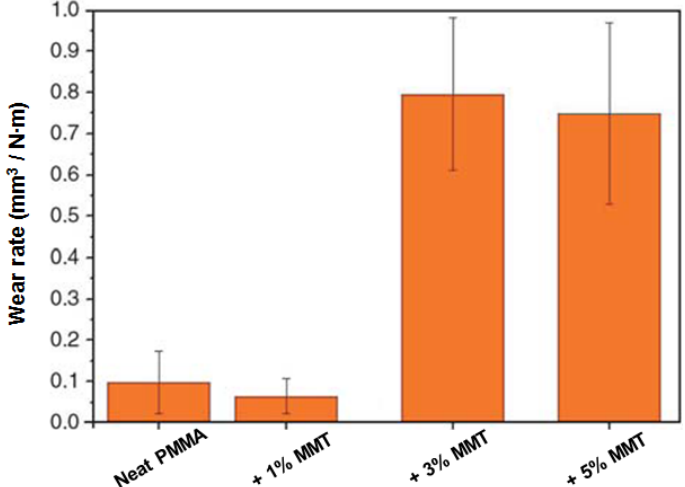
Figure 8. Wear rates for poly(methyl methacrylate) (PMMA) and its composites with MMT. Reprinted from [27] with permission of the copyright holder.